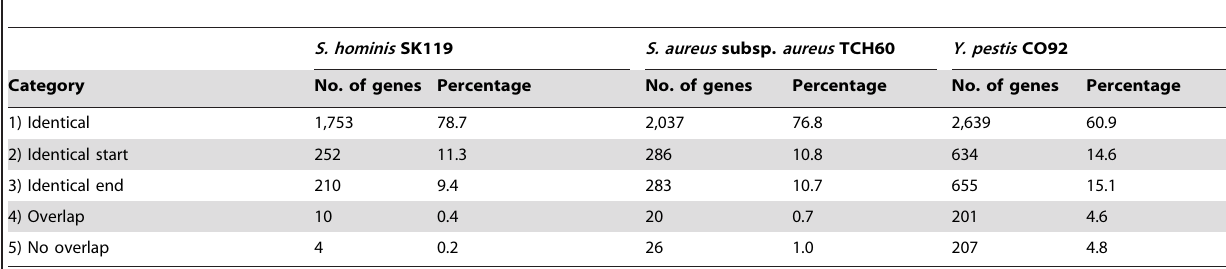
Table 3. Detailed comparison of overlapping gene segments for the three analyzed genomes, displaying the number and percentage of genes in each